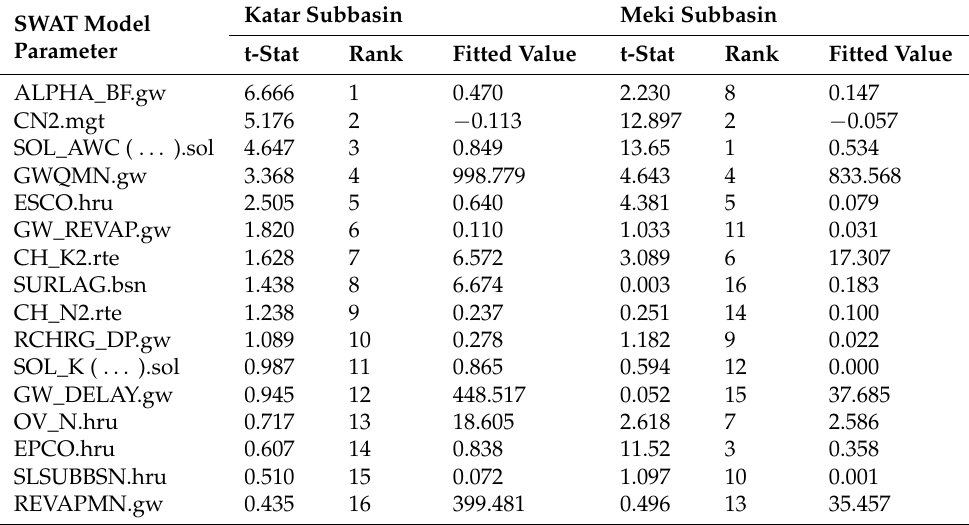
Table 4. Sensitivity analysis of SWAT parameters for Katar and Meki